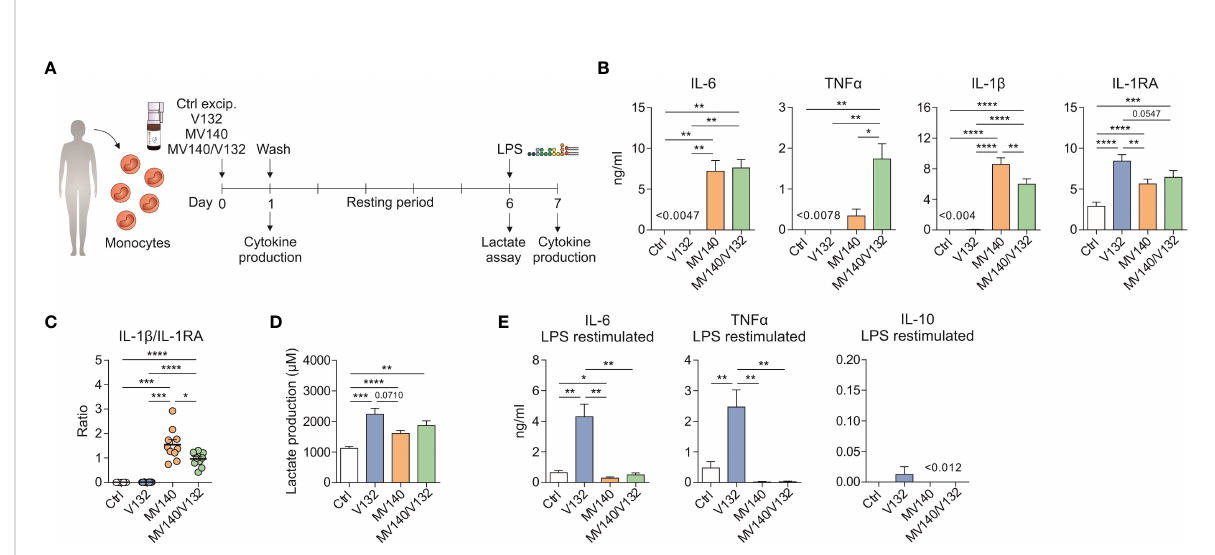
FIGURE 3 V132 induces trained immunity in human monocytes. (A) Human in vitro model for the induction of trained immunity in human monocytes. (B) Cytokine production after stimulation of human monocytes with control excipients (ctrl), V132, MV140 or MV140/V132 for 24 h in cell-free supernatants (n = 10 donors of four independent experiments). (C) IL-1 b /IL-1RA ratio produced by human monocytes after 24 h in the indicated conditions (n = 10 donors of four independent experiments). (D) Lactate production by human monocytes 6 days after 24 h stimulation with ctrl, V132, MV140 or MV140/V132, followed by rest in culture media (n = 11 donors of four independent experiments). (E) Monocytes were incubated for 24 h with ctrl, V132, MV140 or MV140/V132. On day 7, after 24 h restimulation with LPS, IL-6, TNF a and IL-10 concentration in the supernatants were measured (n = 10 donors of four independent experiments). Values are mean ± SEM. Statistical signi fi cance was determined using One-way ANOVA. *P < 0.05, **P < 0.01, ***P < 0.001, and ****P <